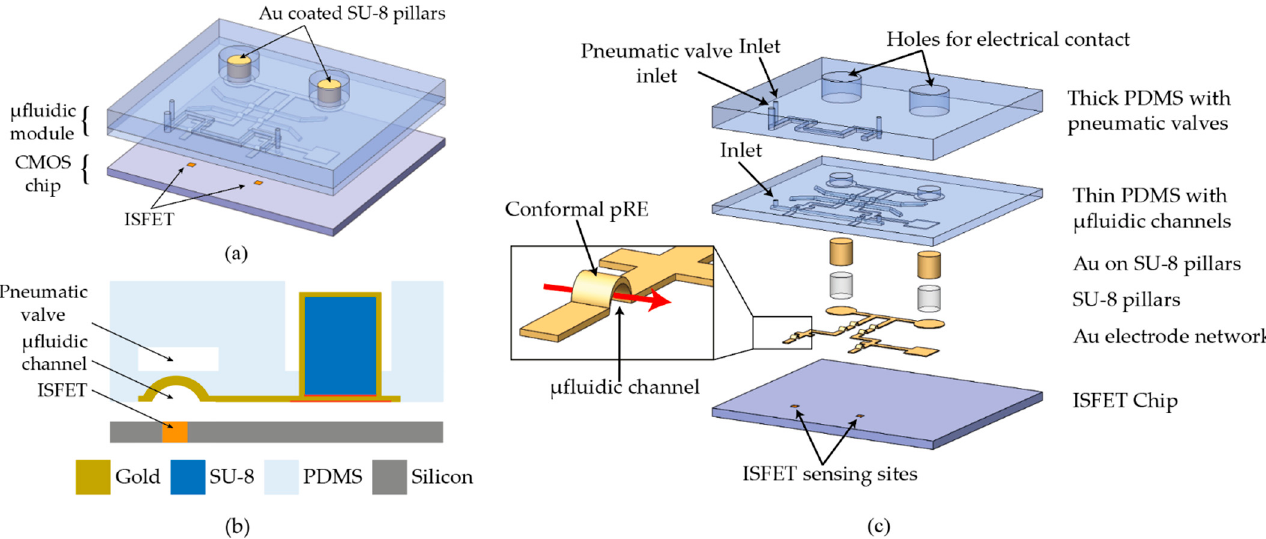
Figure 1. ( a ) 3D schematic of the microfluidic module on a CMOS chip consisting of two nanoliter sized chambers that are created upon actuation of a pneumatic valve. ( b ) Cross-sectional schematic of the module showing the metal-coated “through-PDMS-vias”. ( c ) Exploded view of the microfluidic module showing the comprising layers. Inset shows conformal pseudo-RE with liquid flow (red arrow) in the microchannel.